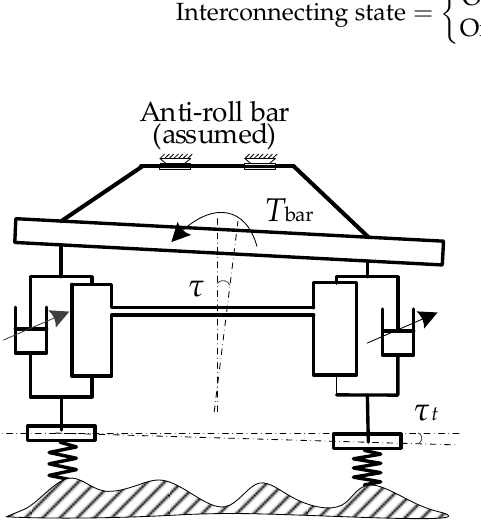
Figure 5. The model of imitated sky-hook interconnected mode control.